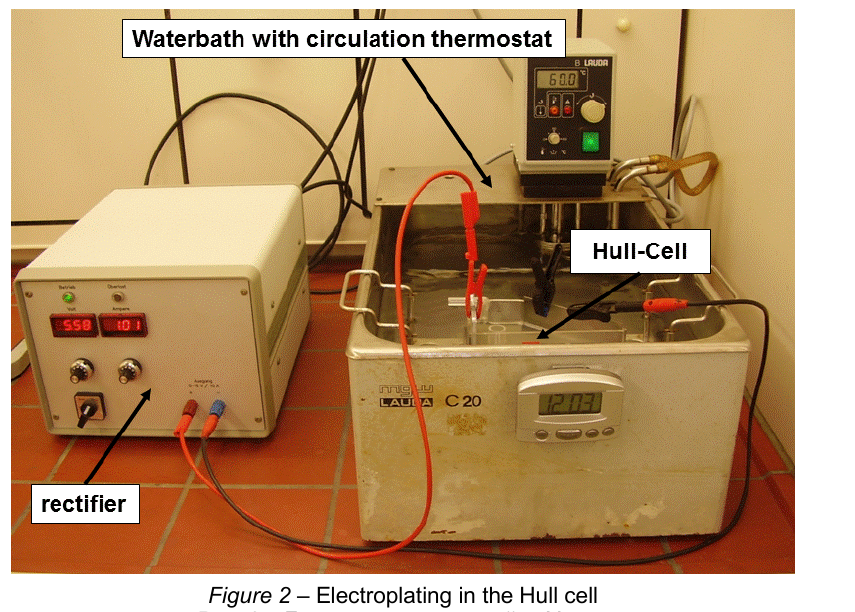
Figure 2 – Electroplating in the Hull cell Рис . 2 – Гальванизация в ячейке Хулла